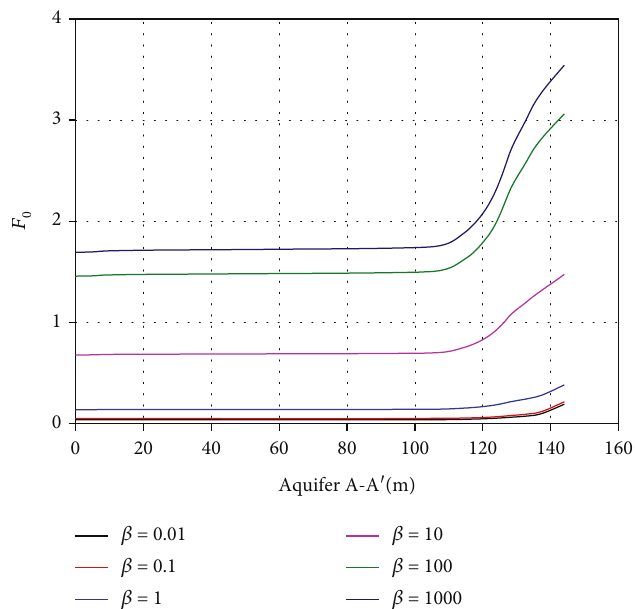
Figure 6: Forchhneimer number at di ff erent permeability ratios in aquifer A- A ′